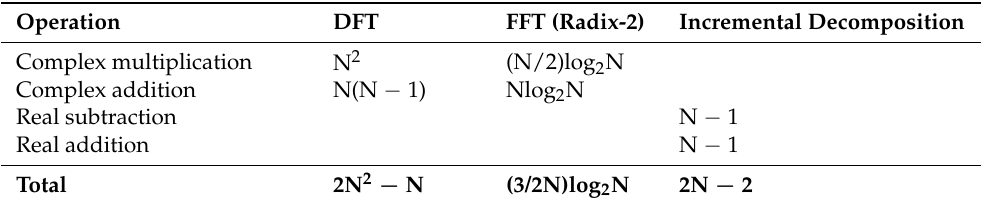
Table 1. Computational complexity of Discrete Fourier Transform (DFT), Fast Fourier Transform (FFT), and incremental decomposition.